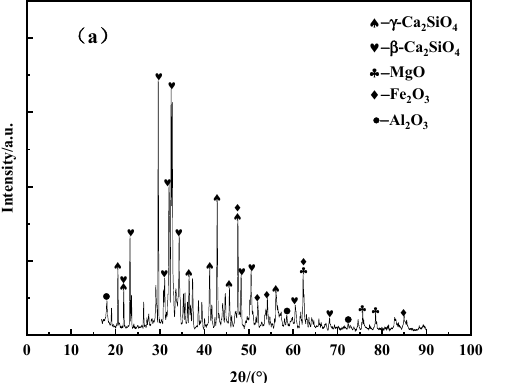
Figure 1. Phase analysis of magnesium slag: ( a ) magnesium slag A, ( b ) magnesium slag B.